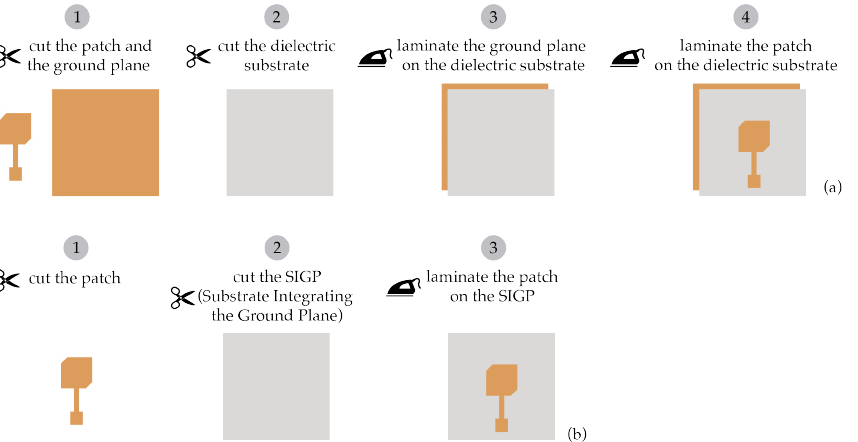
Figure 3. Comparison between the step-by-step of the laminating manufacturing technique, where ( a ) is the typical process used to assembly textile antennas, and ( b ) is the process to assemble textile antennas that uses Substrate Integrating the Ground Plane (SIGP) as dielectric substrate.